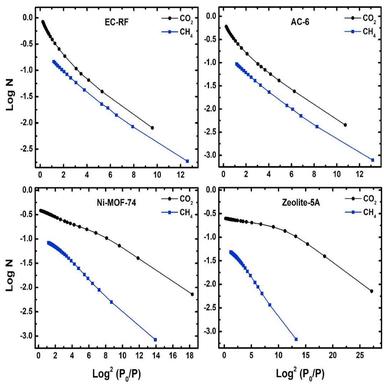
Dubinin-Rudushkevich (DR) plots obtained by applying the DR equation on CO2 and CH4 isotherms (20 bar/298 K). By interpolating the linear parts of the curves, micropore volumes can be calculated from the intercepts (quantity adsorbed) and converted to the micropore volume. The correlation coefficients corresponding to the best fits are also included.